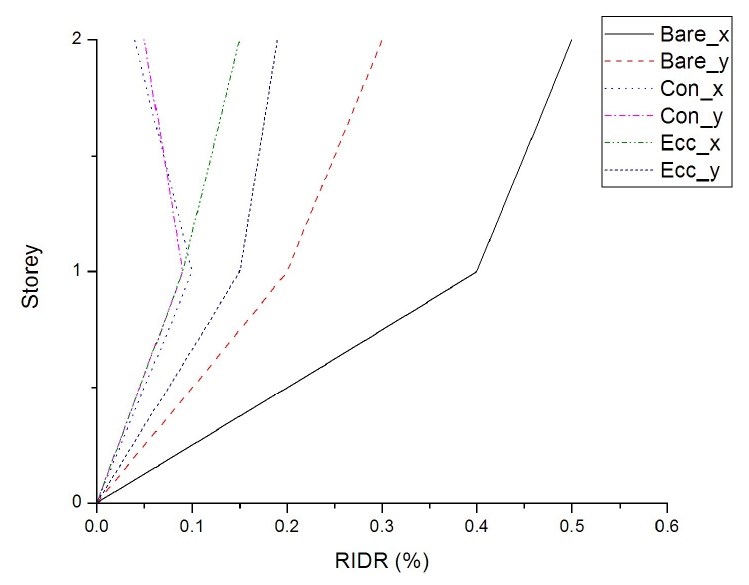
Figure 5. Distribution of peak RIDR for the RC building with and without the seesaw system, sub- jected to seismic motion No. 4 of Table 3.